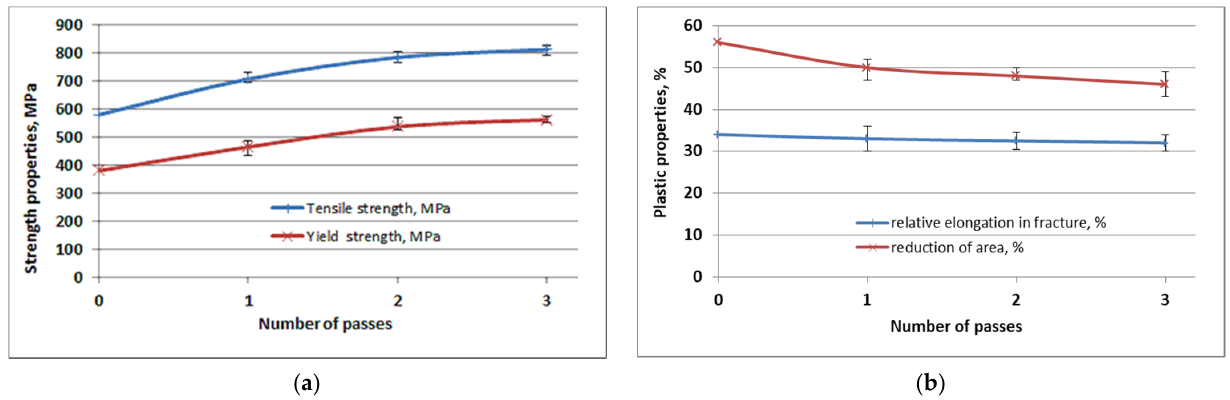
Figure 4. Graphs of mechanical properties with error bars: ( a ) strength properties; ( b ) plastic properties.